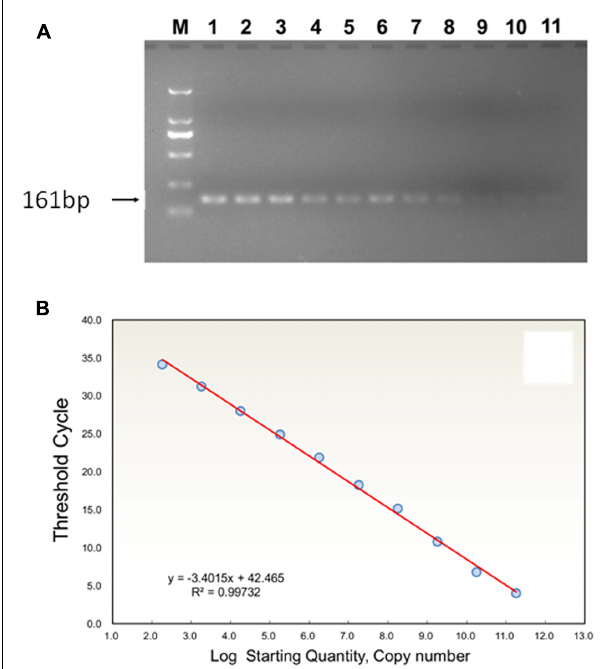
FIGURE 1 | (A) Agarose gel analysis of TYLCV (TYLCV means tomato yellow leaf curl virus) using serial dilutions of plasmid standard product DNA, showing the amplification products obtained by PCR with TYLCV; M: 161-bp ladder DNA marker. Standards (copy numbers per µ l of target DNA): 1, 9.16 × 10 10 ; 2, 9.16 × 10 9 ; 3, 9.16 × 10 8 ; 4,9.16 × 10 7 ; 5, 9.16 × 10 6 ; 6, 9.16 × 10 5 ; 7, 9.16 × 10 4 ; 8, 9.16 × 10 3 ; 9, 9.16 × 10 2 ; 10, 9.16 × 10 1 ; 11, 9.16 × 10 0 . (B) Standard curve analysis: the relationship between TYLCV concentration and corresponding Ct value is shown by linear regression equation of Ct (x) transformed into log (starting